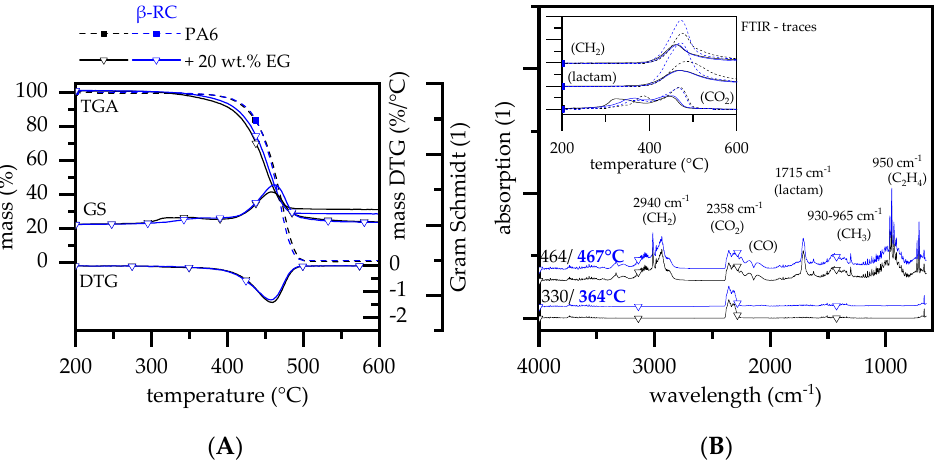
Figure 4. TGA, DTG, Gram Schmidt and FTIR (Gas) curves determined at a heating rate of 20 K/min. ( A ) TGA, DTG Gram Schmidt for PA6 containing 20 wt.% EG; ( B ) corresponding FTIR peak spectra. A slight difference to non ‐β‐ RC net PA6, marking a DTG peak at 468°, was attributed